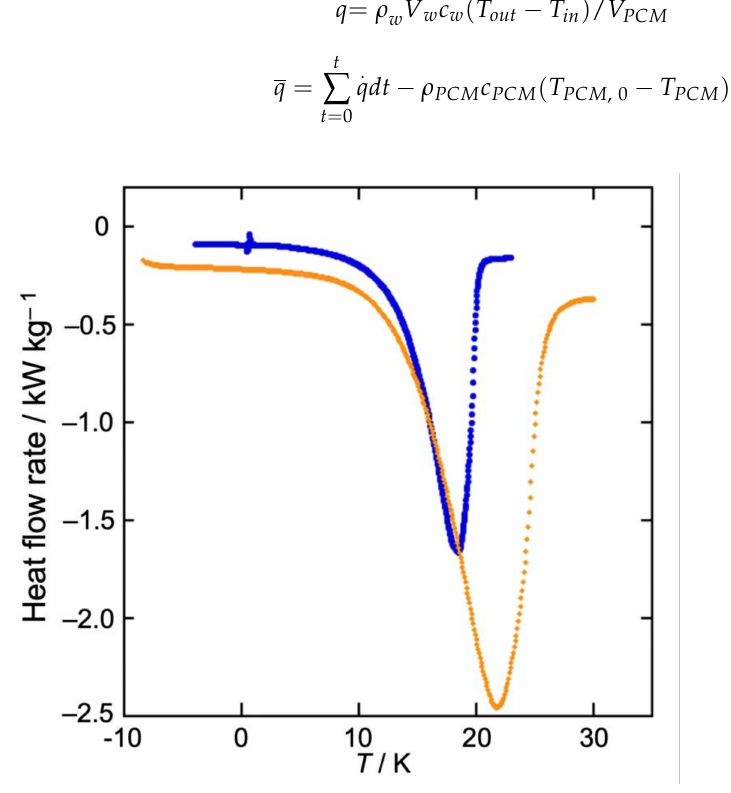
Figure 2. The DSC heating curves measured at w TBAAc = 0.33 and 0.36. • : w TBAAc = 0.36, (cid:117) : w TBAAc = 0.33.